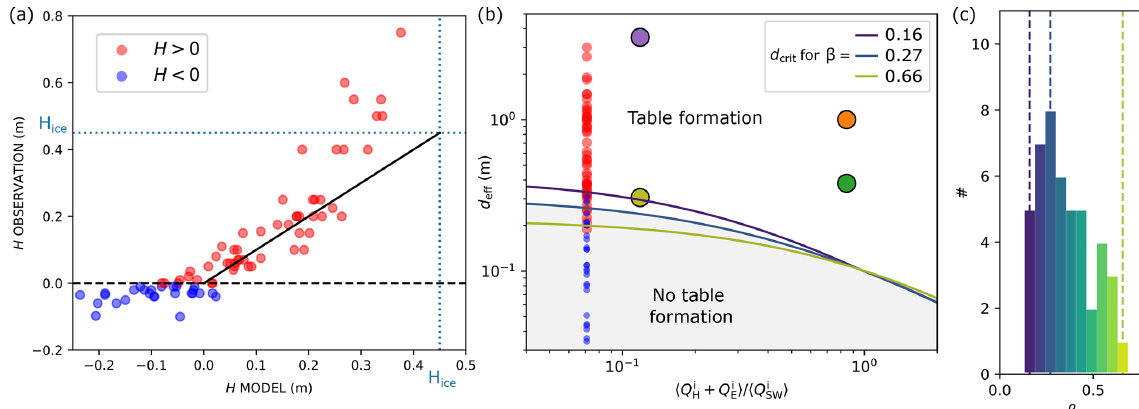
Figure 8. (a) Observation versus model for the distance H between the bottom of rocks and the ice surface for the data measured on 3 June 2021 (see Fig. 3). The data are represented in red if a table is observed ( H > 0) and in blue otherwise. The solid black line has a slope of 1, and the dotted lines correspond to the ablated ice thickness H ice since the melting of the snow layer (see the Supplement). (b) Diagram of the ability of a rock to form a table as a function of its typical width d eff and the ratio (cid:104) Q i three values of the aspect ratio β , to the delimitation predicted by the model with averaged meteorological data, between a rock forming a table and a rock sinking into the ice surface. The small circles correspond to the data of (a) with the same colour code. The larger circles correspond to rocks 1–4. (c) Distribution of the aspect ratio β of the rocks close to the transition between the two regimes ( | H | < 0 . 2m). The vertical dashed lines correspond to the limits plotted in (b) with the same colour